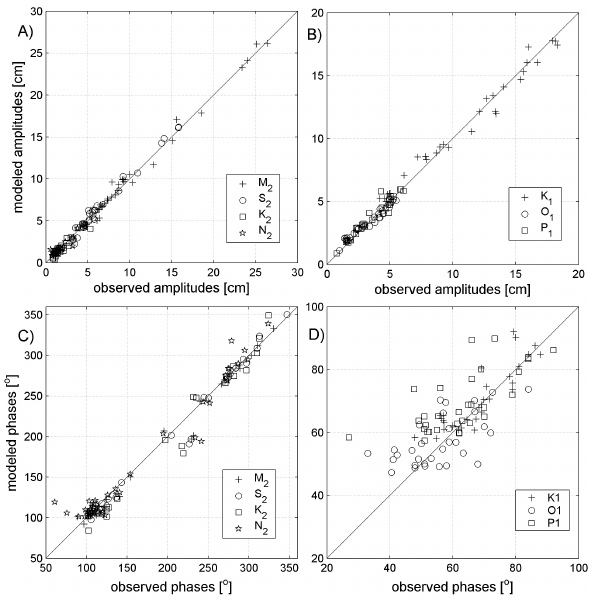
Fig. 9. Comparison of the observed and model-predicted (A) semid- iurnal, (B) diurnal constituent amplitudes and (C) semidiurnal, (D) diurnal constituent phases at 31 gauge stations.